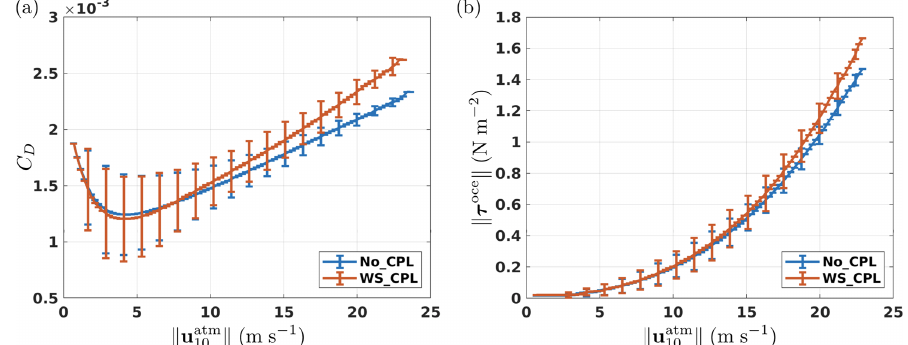
(cid:107) and (b) wind stress norm (cid:107) τ oce (cid:107) as a function of (cid:107) u atm 10